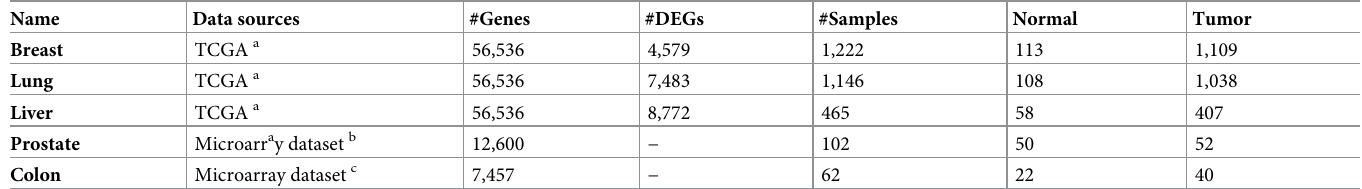
To test the feature selection performance of the GSEA–SDBE method, a simplified version, named Pre-SDBE, which does not use GSEA to filter out genes weakly associated with or unre- lated to cancer, was used. swarm optimization (PSO) algorithm, and cuckoo optimization algorithm and harmony search (COA-HS). These algorithms use 100 relevant genes selected via the minimum redun- The classification performance of Pre-SDBE was compared with that of the three advanced genes expressed in prostate and colon cancers (Table 5). Table 5. Information on the datasets used for performance